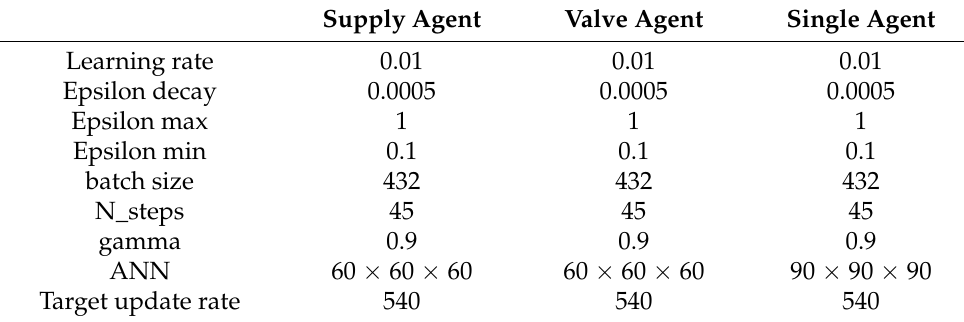
Table 6. Hyperparameters used for training the agents.